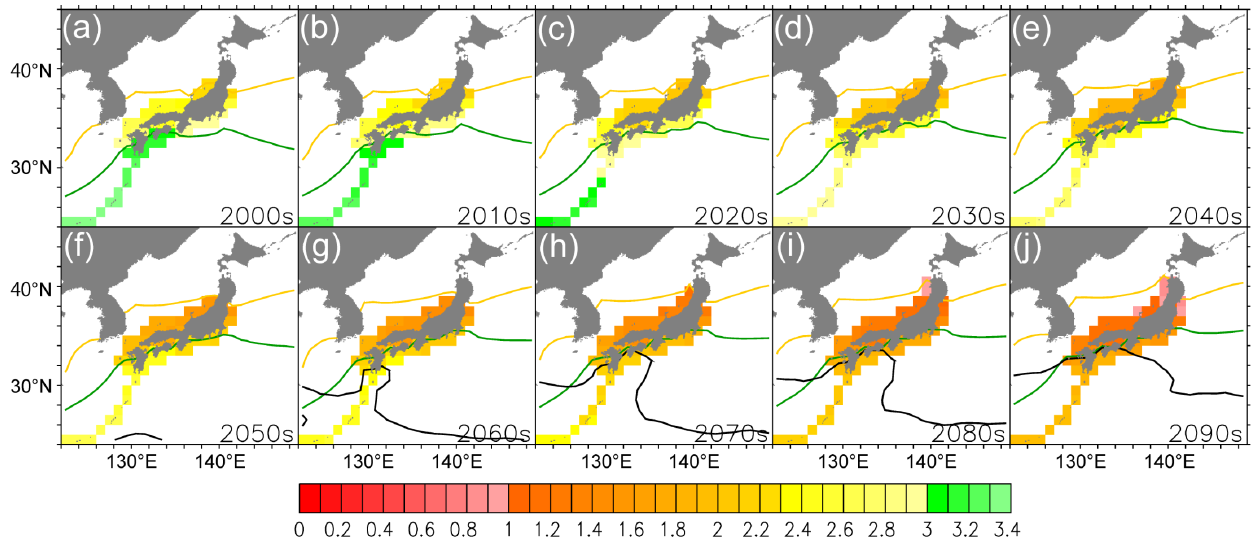
Fig. 3. Projected 10-yr average SST for the coldest months and (cid:127) arag as the annual lowest value during 2000s–2090s for the mean of four models. Lines depict the isolines of SST=18 ◦ C (green lines) and SST=10 ◦ C (yellow lines) during the coldest months, and the SST isoline=30 ◦ C (black lines) during the hottest months. Shades denote the annual lowest (cid:127) arag